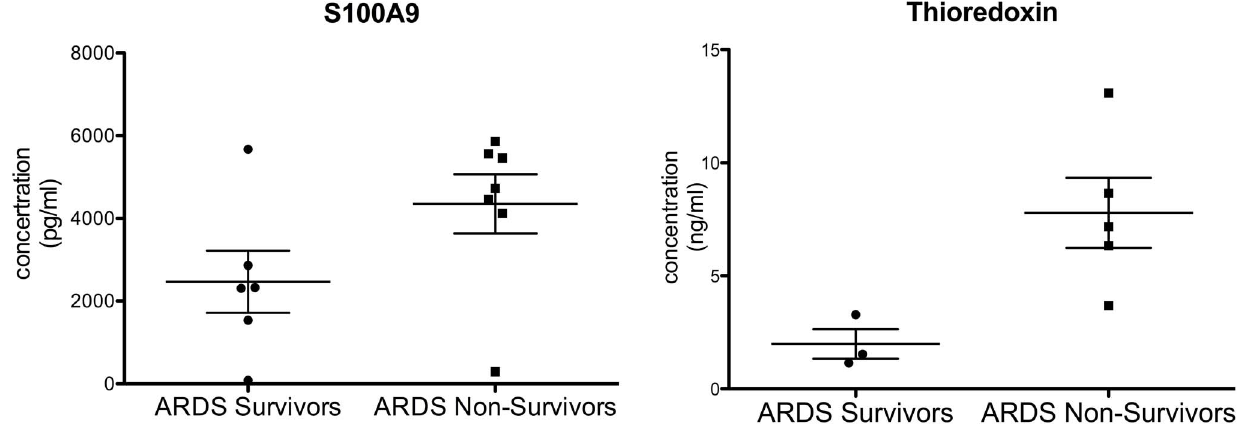
Figure 5. Protein levels of selected proteins that represented biological processes that are activated in early phase non-survivors. Thioredoxin was identified in only 3 survivors. (p-value , 0.05 thioredoxin and , 0.1 for S-100).